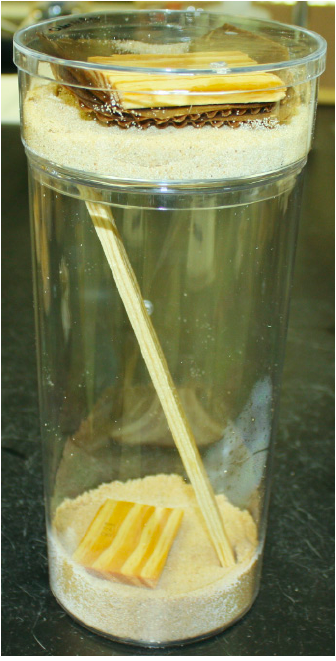
Figure 1. Bioassay arena showing top and bottom foraging sites connected with a ramp.